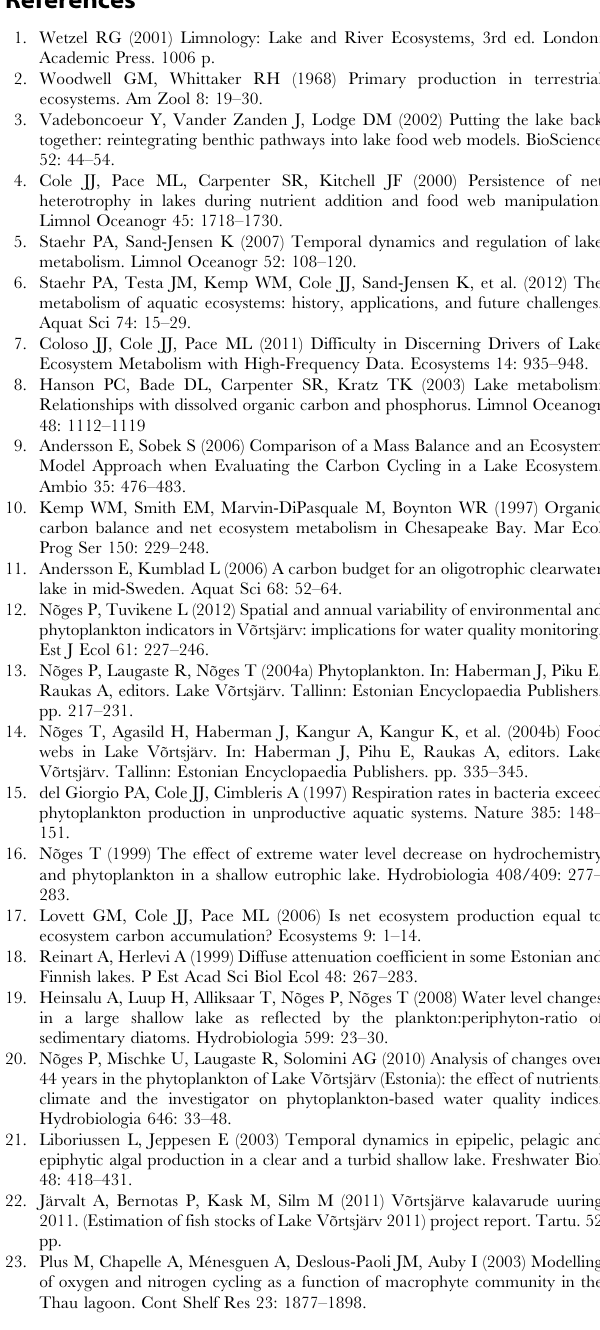
Table S1 Parameter database for functional group metabolic measurements. Table S2 Composition of benthic and planktonic com- munities in the 2009–2011